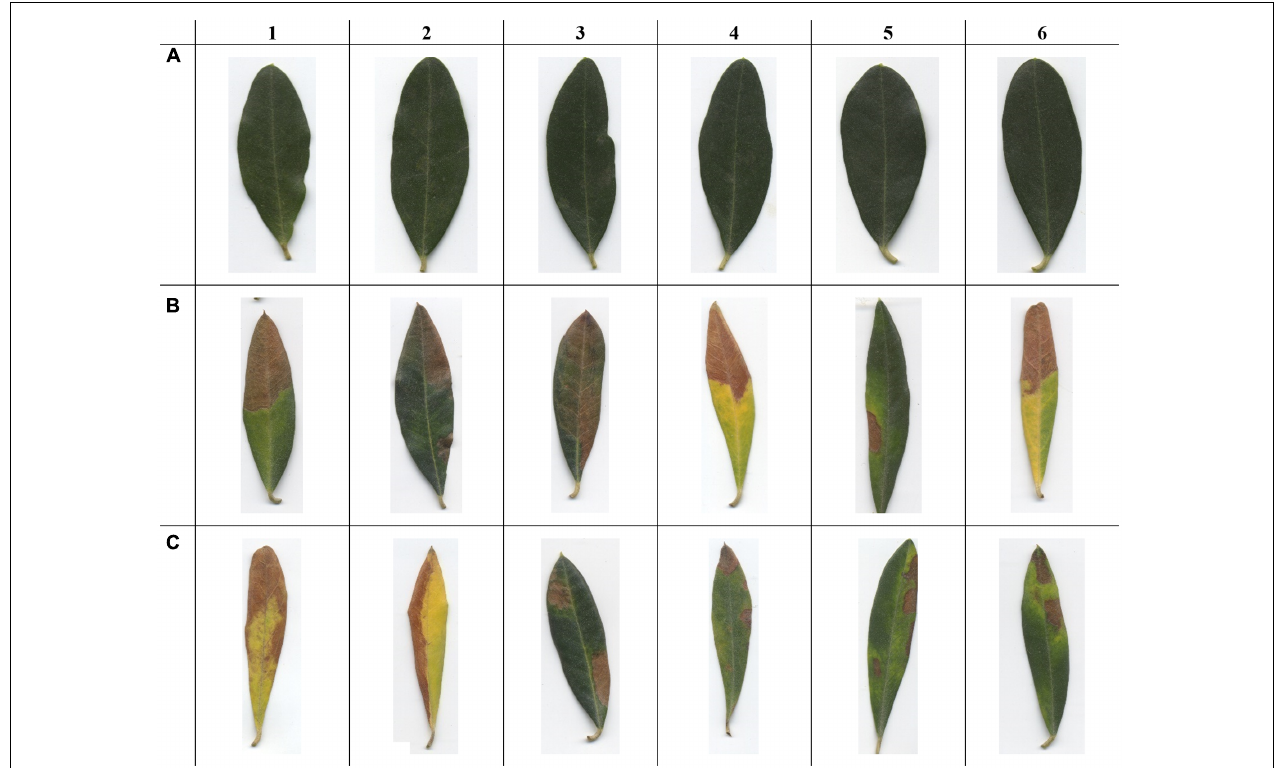
FIGURE 4 | Examples images of Olea europaea L. used in this study. (A) Healthy control (asymptomatic leaves); (B) OQDS-symptomatic leaves ( Xylella fastidiosa -positive samples); (C) X. fastidiosa -negative samples showing another pathogen/disorder. Note that the images given here are the native, original aspect ratio of O. europaea L. leaves. It is easy to distinguish healthy leaves from non-healthy leaves ( A vs. B or C ). However, tissue desiccation on the leaf tip, if it occurs, is not exclusive to OQDS (C1, C4, and C6), thus it is challenging to detect the difference between OQDS and non-OQDS samples ( B vs. C